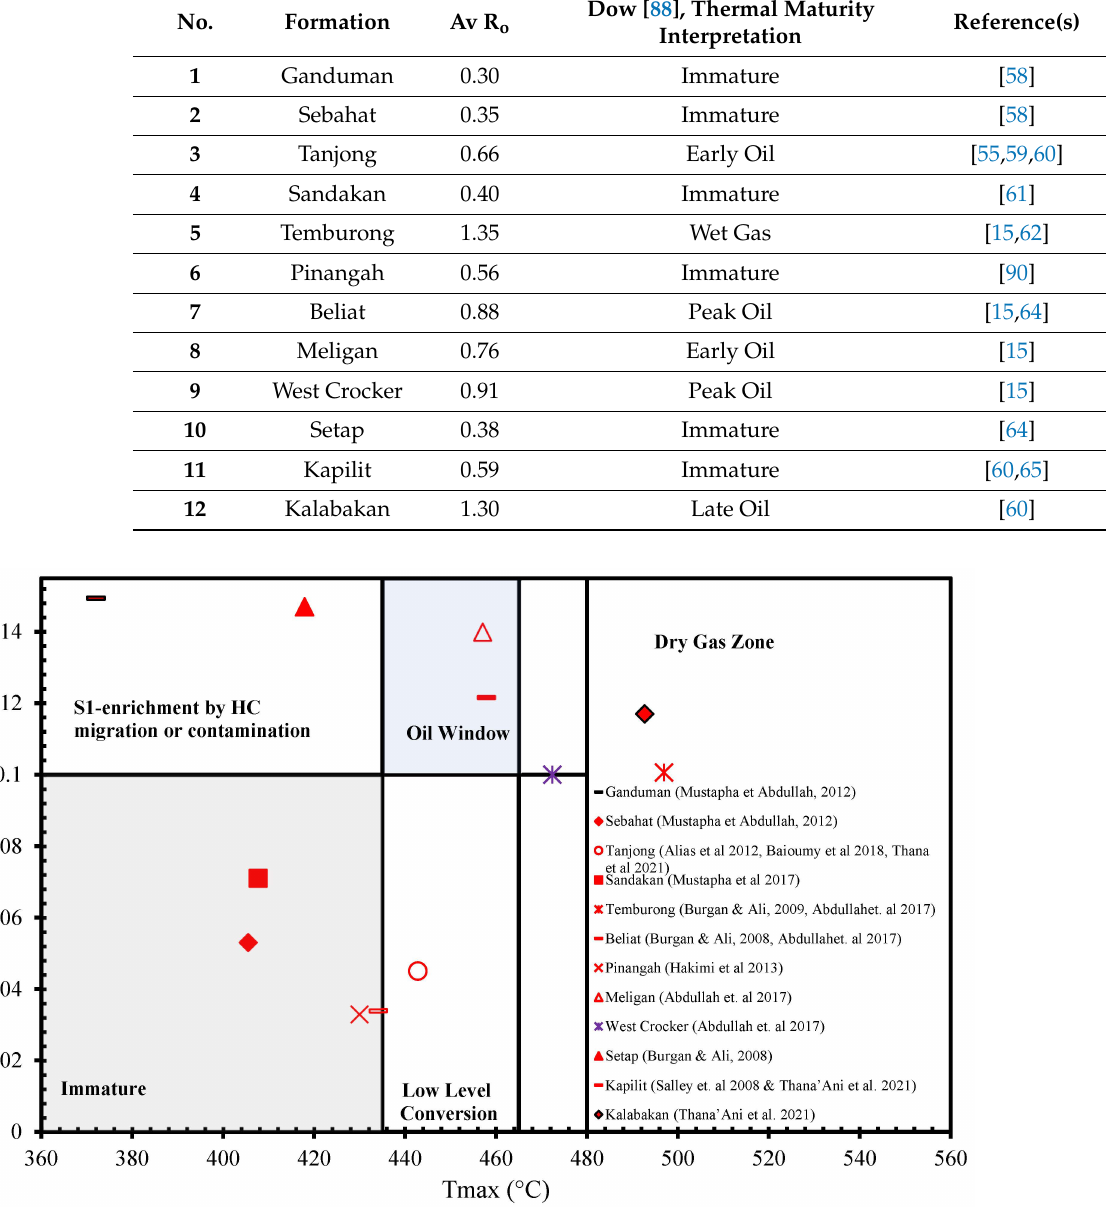
Table 11. Thermal maturity interpretation of formations in Sabah according to Dow [88] using R o .